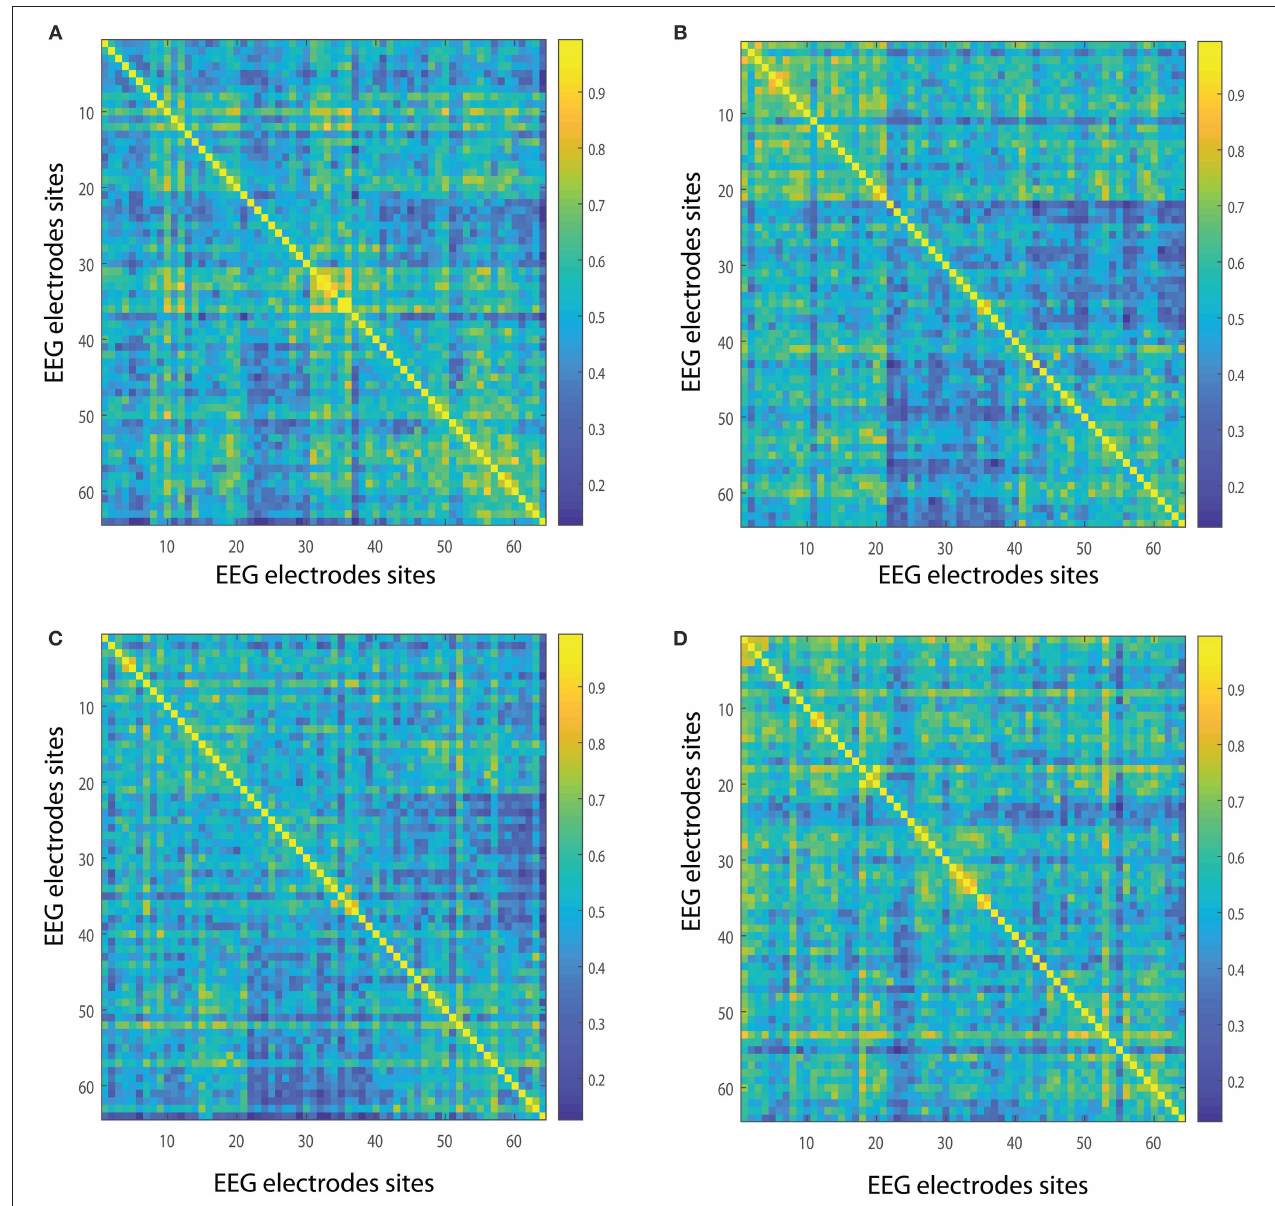
FIGURE 4 | Network interconnectivity. (A,B) Show the network averaged values of the interconnectivity considering 109 subjects when performing the visuomotor task for the 64-channel EEG considering the different oscillation bands beta 1 and beta 2. (C,D) Are the same as (A,B) but considering the imagined task. We consider D = 6 and τ = 1. Beta 1 oscillation band corresponds to [13,18) Hz and beta 2 oscillation band to [18,31) Hz .